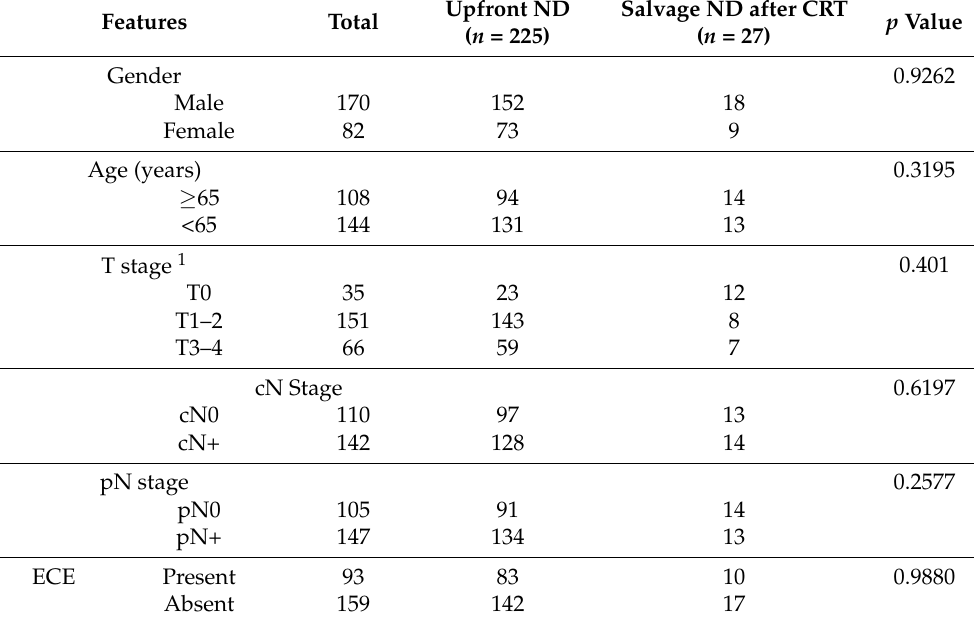
Table A1. Patients clinical and pathological features prior and after CRT. N =